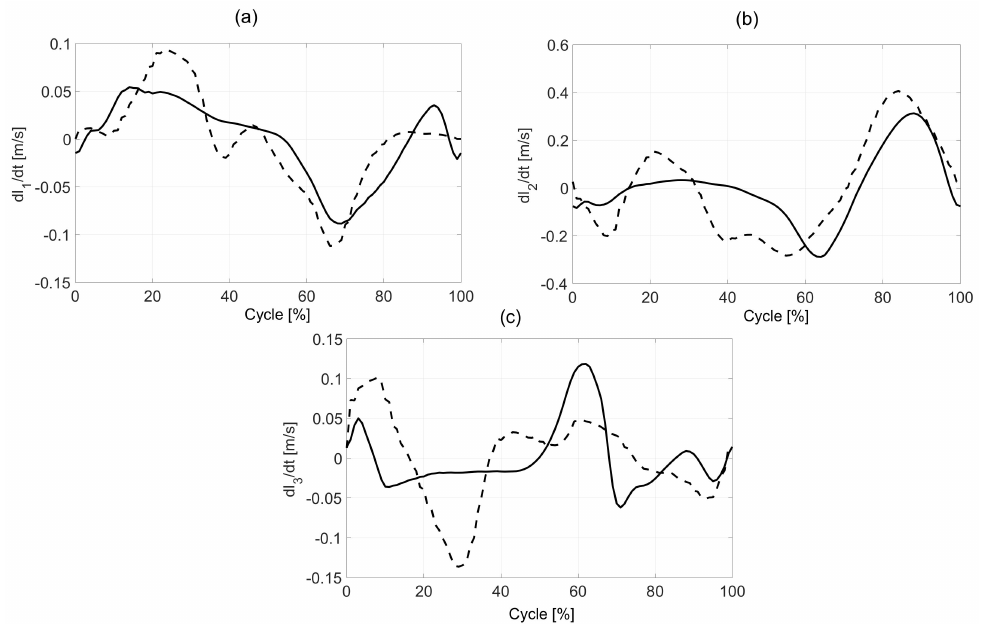
Figure 8. The actuators velocities during walking (—) and running (---): Hip actuator ( a ), knee actuator ( b ), and ankle actuator ( c